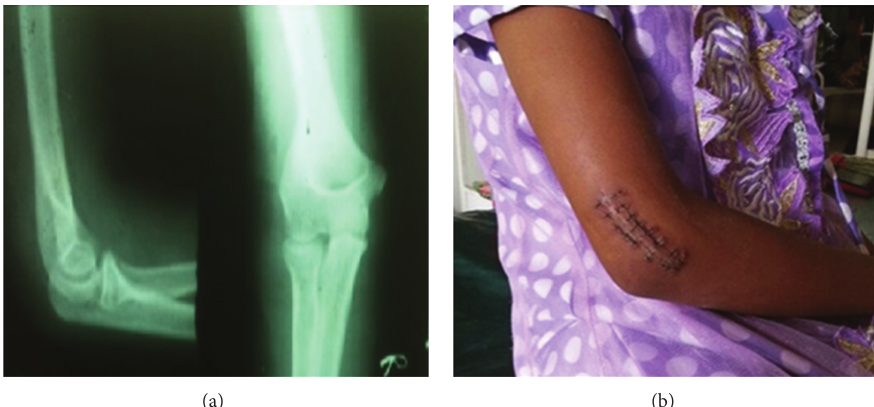
Figure 2: (a) Postoperative radiograph at 1-year follow up showing no evidence of recurrence. (b) Postoperative scar photograph after excision